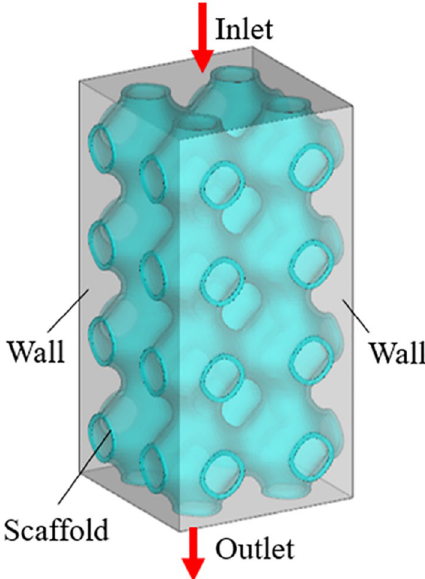
Figure 4. Boundary conditions of CFD